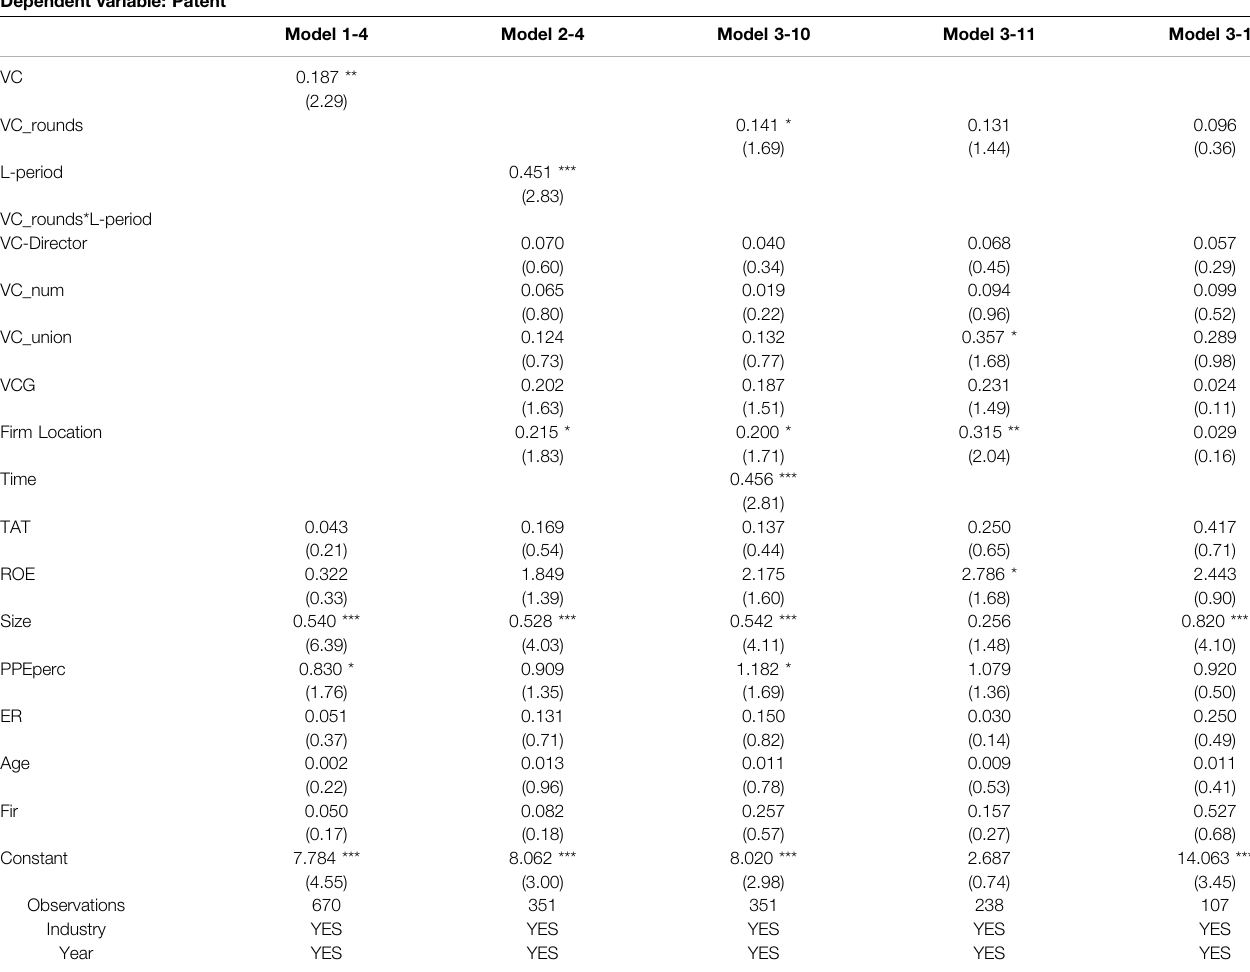
TABLE 8 | Regression results of changing measurement methods. Dependent variable: